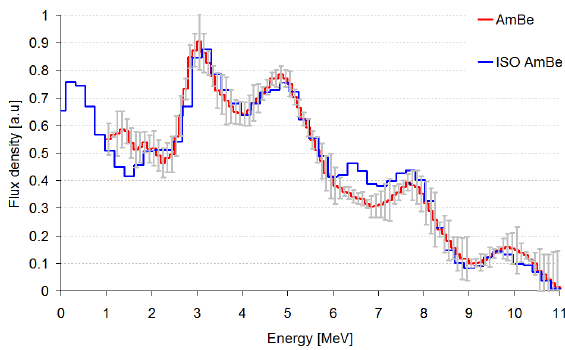
Figure 1. Measured AmBe spectra compared with tabulated val-